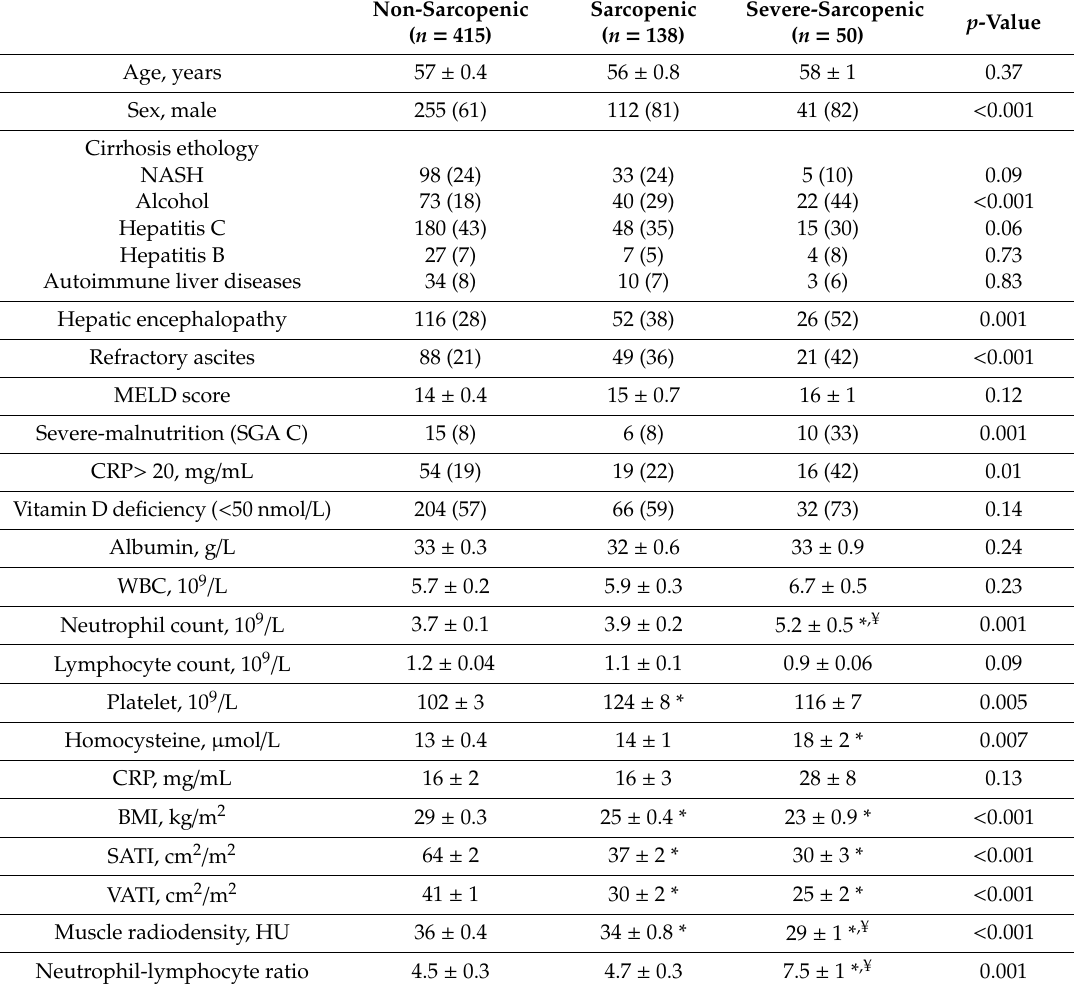
Table 3. Clinical characteristics and metabolic profile of patients with cirrhosis and di ff erent severity of